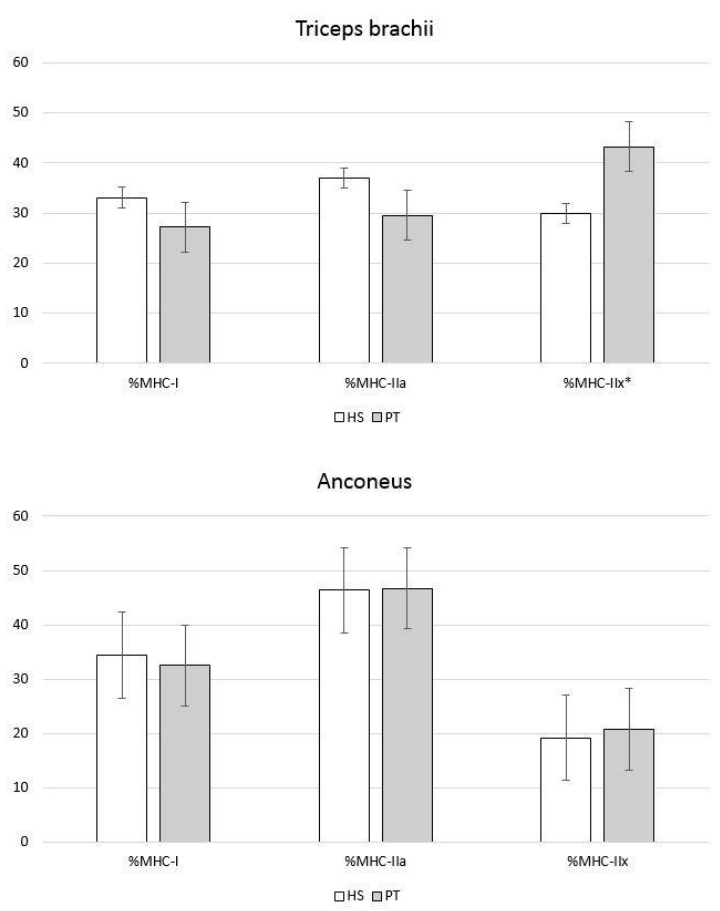
Figure 4. Expression of MHC isoforms in the triceps brachii and anconeus in Homo sapiens and Pan troglodytes . MHC = myosin heavy chain; HS = Homo sapiens; PT = Pan troglodytes . The data bars represent mean values, and the error bars represent the standard error. * indicates statistical significance.